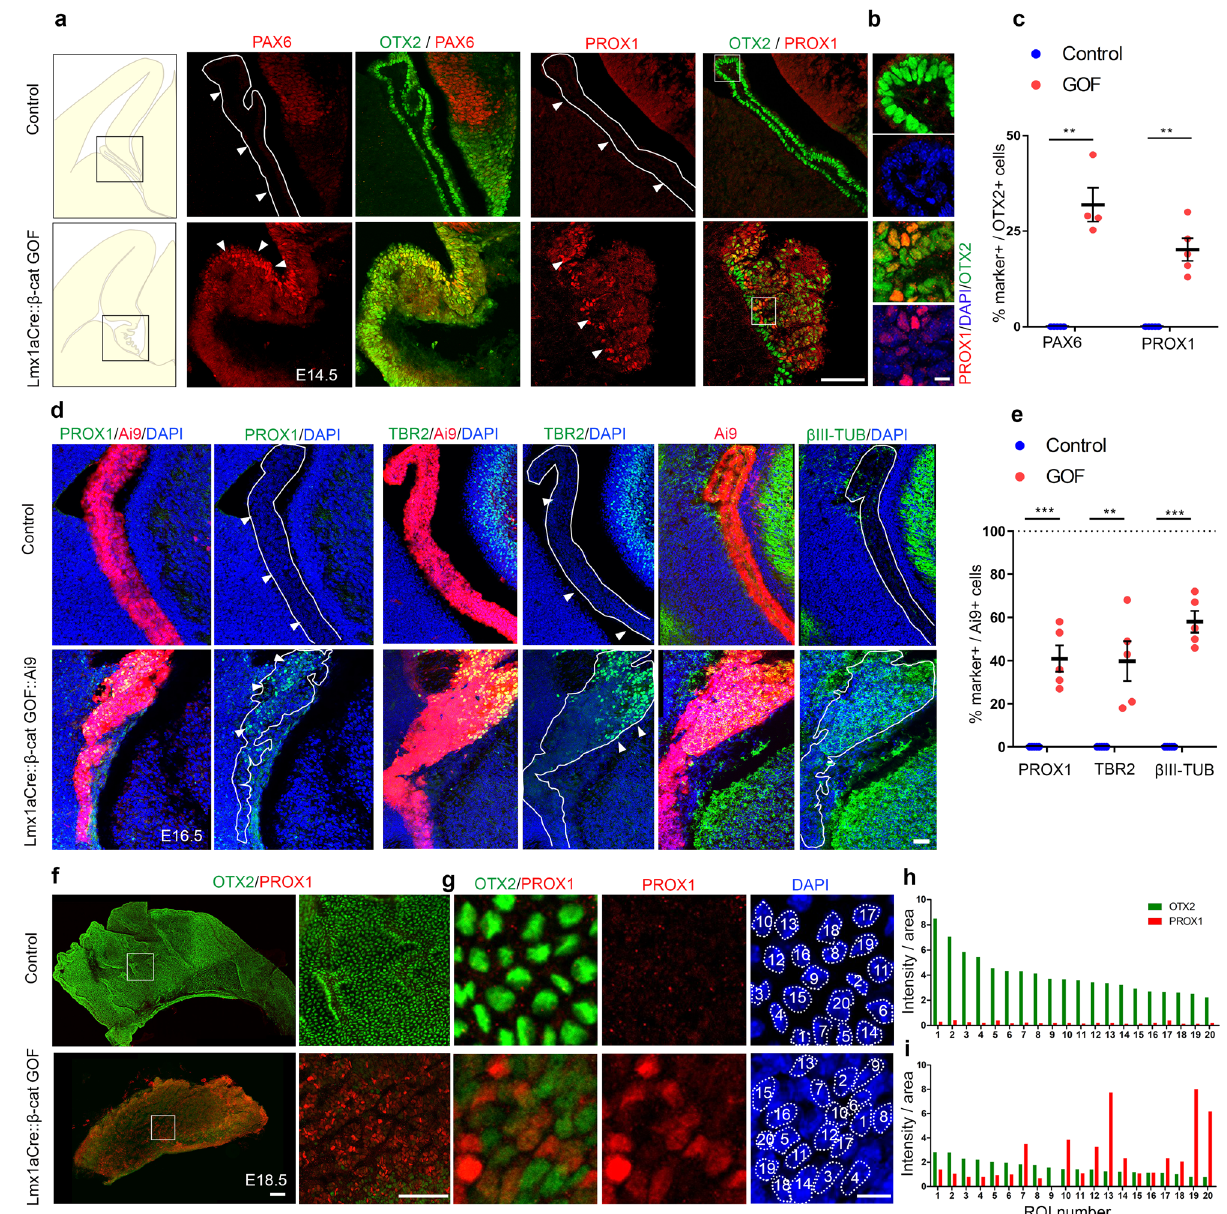
Fig. 4 Constitutive activation of β -catenin transforms the ChPe to a neuronal and hippocampal-like molecular identity. ( a – c ) At E14.5, the control ChPe is positive for OTX2 but not PAX6 or PROX1. In the control brains 0% OTX2 + cells are also PAX6 + / PROX1 + whereas in Lmx1aCre:: β -cat GOF ChPe, 31.9% of the OTX2 + cells are also PAX6 + and 20.3% are PROX1 + . Boxed regions ( a ) are shown at high magni fi cation in the adjacent panels ( b ). ( c ) N = 4 (PAX6), N = 5 (PROX1) brains (biologically independent replicates) for each genotype were examined over 4 independent experiments. ( d , e ) At E16.5, the Ai9 reporter marks the Lmx1aCre lineage, none (0%) of Ai9 + control ChPe cells are PROX1 + or TBR2 + or, β III TUBULIN + . In Lmx1aCre:: β -cat GOF brains, 41% of the Ai9 + cells co-label for PROX1, 39.8% for TBR2, and 58% for β III TUBULIN. ( e ) N = 5 brains (biologically independent replicates) for each genotype were examined over 5 independent experiments. ( f , g ) E18.5 control and Lmx1aCre:: β -cat GOF wholemount ChP preparations were co- immunostained for PROX1 and OTX2. The Lmx1aCre:: β -cat GOF ChP displays decreased OTX2 labeling and the presence of PROX1 + cells of varying intensities which never appear in control samples. ( h, i ) Intensity quanti fi cation of 20 cells from a single fi eld shows a marked decrease in OTX2 intensity in cells from the Lmx1aCre:: β -cat GOF ChPe, and high levels of PROX1 in some of these cells. ( f , g ) Representative images of sections taken from N = 3 brains (biologically independent replicates) examined over 2 independent experiments. High mag panels in ( f ) show representative z plane of the boxed region. Statistical tests in c and e : two-tailed unpaired multiple Student ’ s t test with unequal variance. For ( c ), p = 0.005442 (PAX6 ) , p = 0.0023 (PROX1); ( e ), p = 0.000156 (PROX1 ) , p = 0.00264 (TBR2), p = 0.000003 ( β III TUB). * p < 0.05, ** p < 0.01, *** p < 0.001, ns if p value > 0.05. Scatter plots ( c , e ) represent mean ± SEM. Scale bars: 100 μ m (all panels in a and f ); 10 μ m (all panels in b and g ); 50 μ m (all panels in d). Further information on replicates and reproducibility for this fi gure is mentioned in the “ Statistics and Reproducibility ” section of the Methods. Source data are provided as a Source Data fi le.